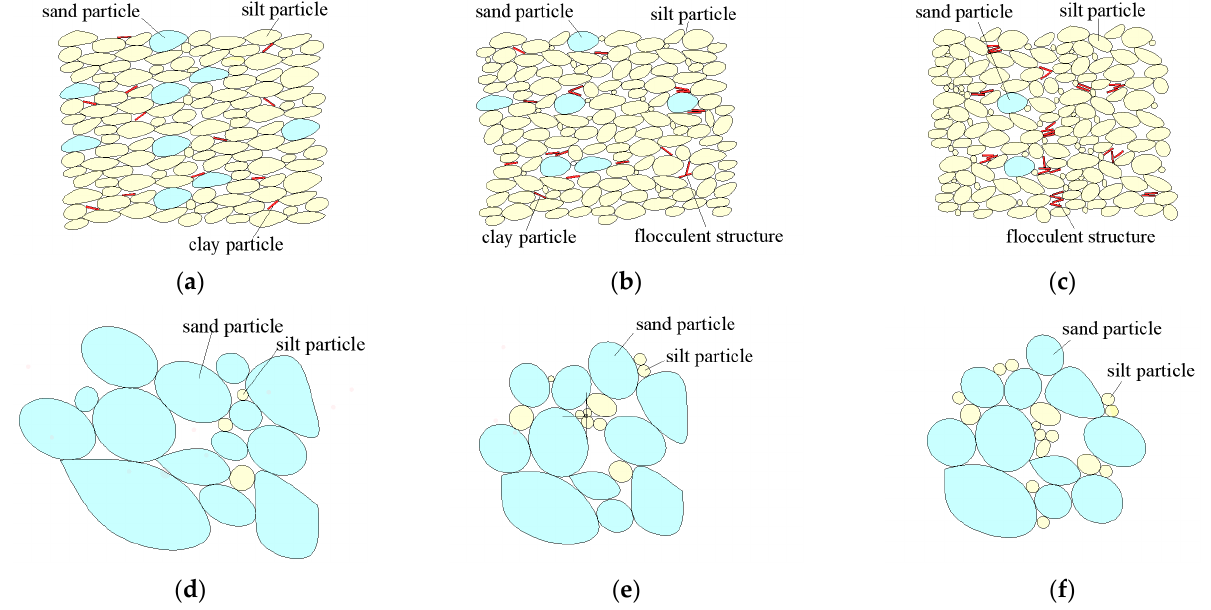
Figure 22. Schematic diagram of soil structure under freeze–thaw action. ( a ) Unfrozen silt; ( b ) silt after initial freeze–thaw cycle; ( c ) silt after long-term freeze–thaw cycles; ( d ) unfrozen sand; ( e ) sand after initial freeze–thaw cycle; ( f ) sand after long-term freeze–thaw cycles.